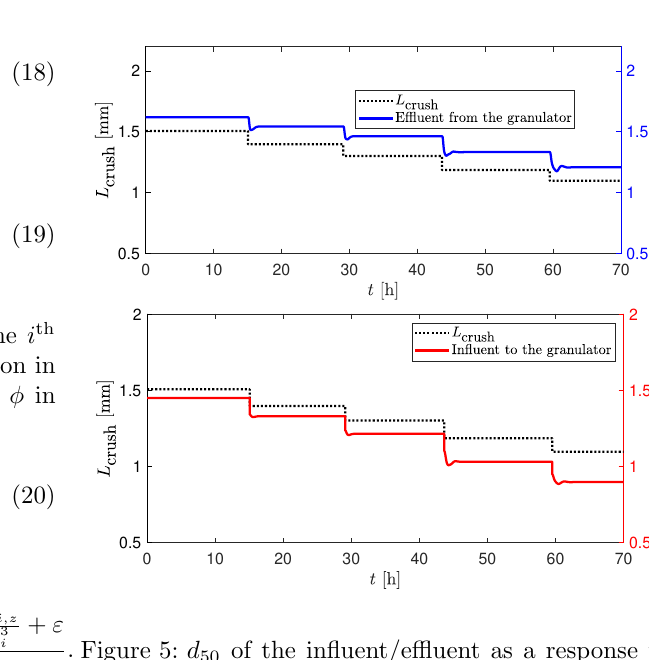
Figure 5: d 50 of the influent/effluent as a response to the step-by-step change of the crusher gap